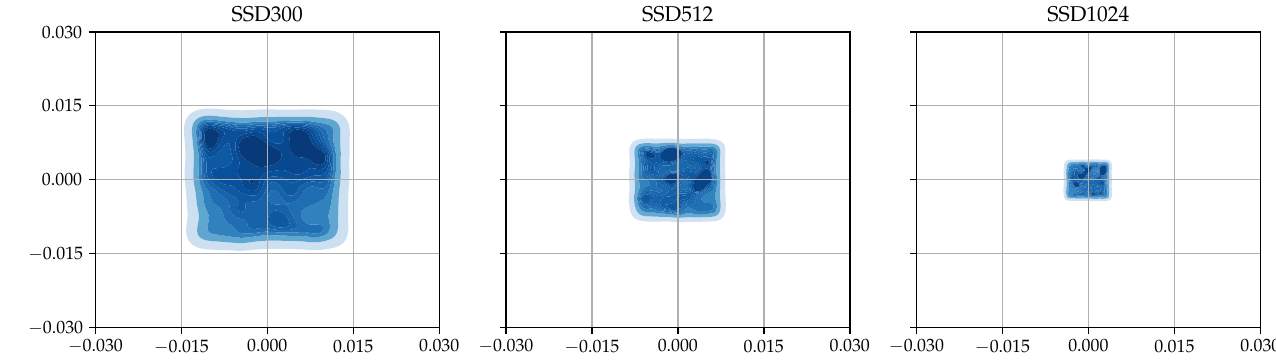
Figure 4. Relative center point distribution obtained from TT100K using aligned matching.